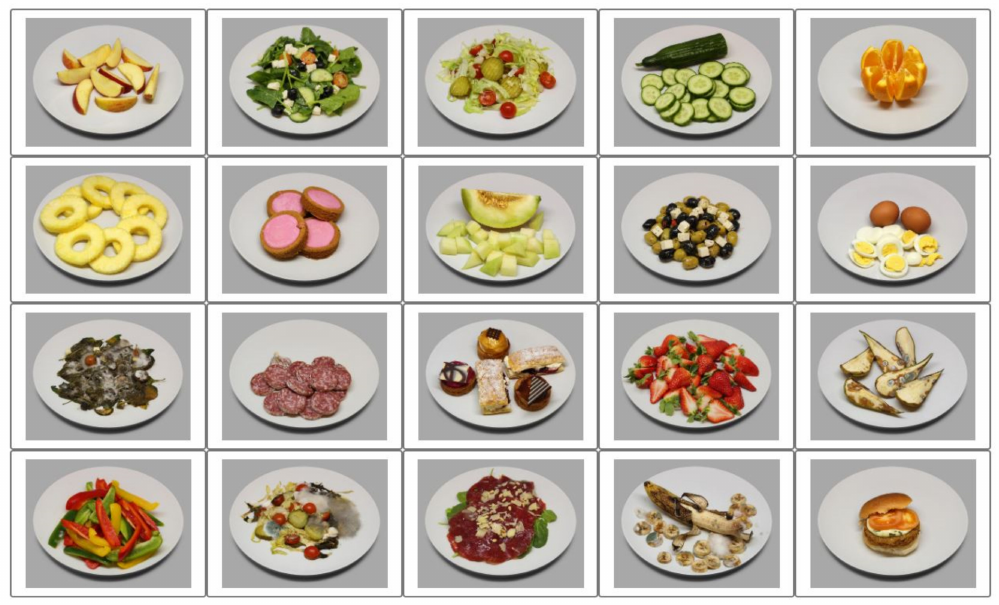
Figure 3. The set of 20 food images used as stimuli in this study (selected from the CROCUFID database